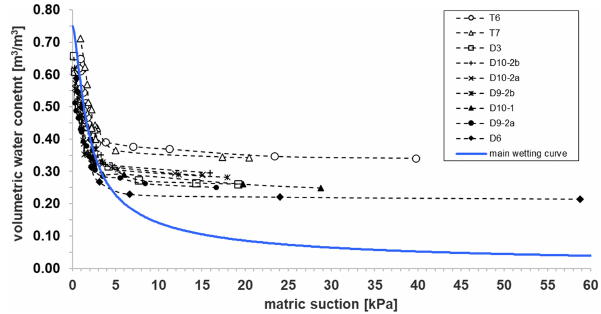
Figure 6. Coupled values of matric suction and volumetric water content measured during infiltration tests (Damiano and Olivares, 2010). The test acronyms shown in the legend are those reported in the repository dataset (Comegna et al., 2020). The main wetting curve is obtained by fitting all the experimental points featuring ma- tric suction values lower than 4kPa with the van Genuchten Eq. (1). The fitted van Genuchten parameters are shown in Table 2. Table 2. Van Genuchten parameters (Eq. 1) fitted to the main wet- ting curve shown in Fig. 6: saturated volumetric water content, θ s ; residual volumetric water content, θ r ; and parameters α , n , and m